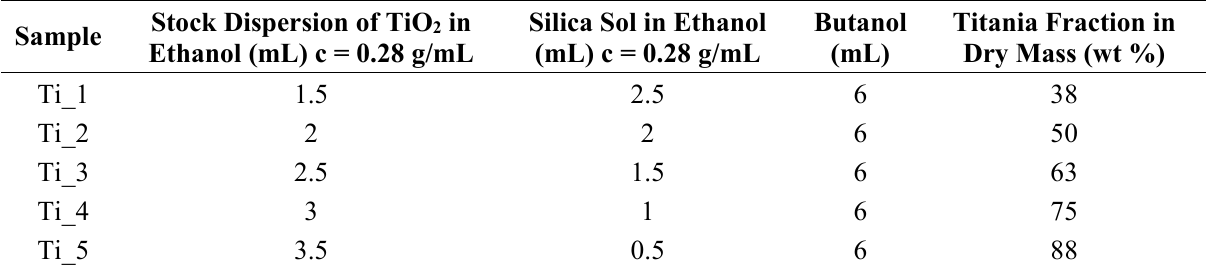
Table 4. Composition of printing